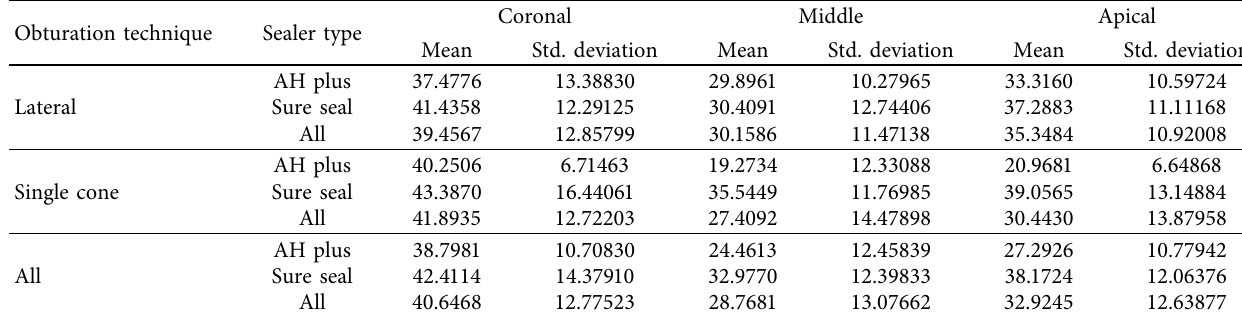
Table 4: Mean sealer percentage in the study groups.